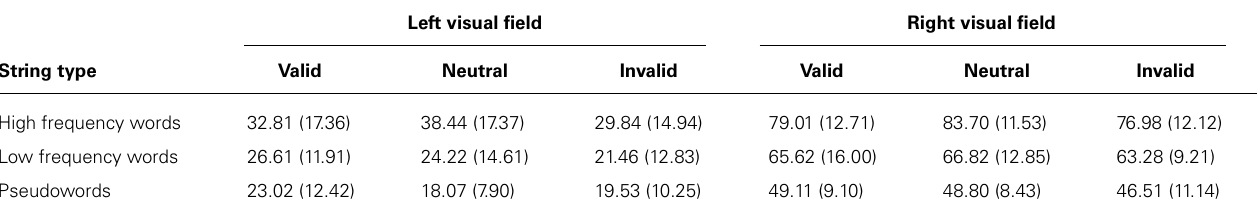
Table 1 | Mean accuracy (in percentage of correctly reported letters) and standard deviation (in parenthesis) for all conditions in the experiment.